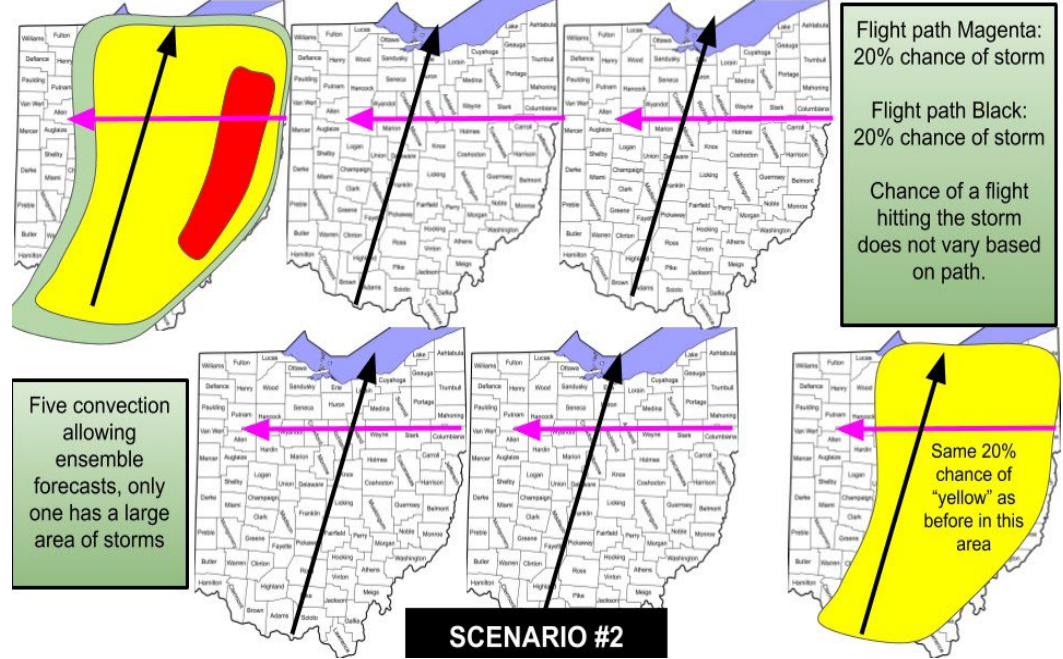
Figure 26. Five hypothetical ensemble convection forecasts, with two hypothetical flight paths. Each has a 20% chance of being impacted due to uncertainty in convection happening rather than uncertainty in location.